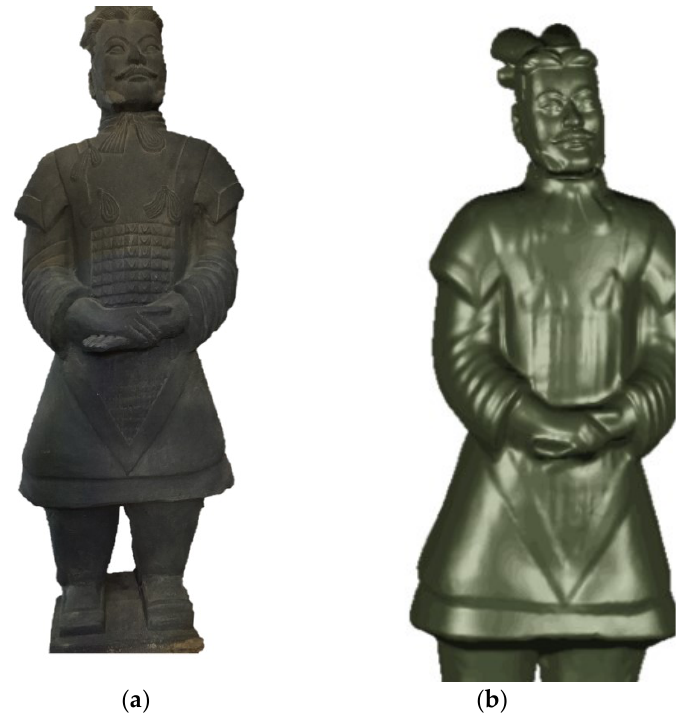
Figure 6. Field map. ( a ) Terra Cotta Warrior; ( b ) 3D reconstruction.